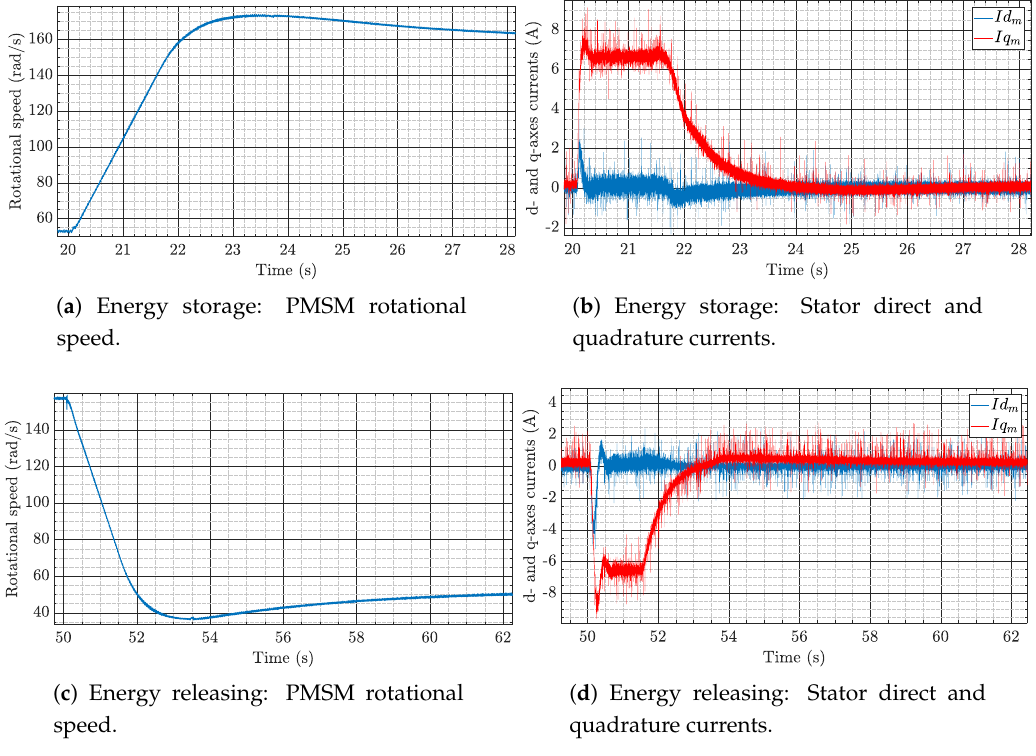
Figure 13. Machine-side converter experimental results